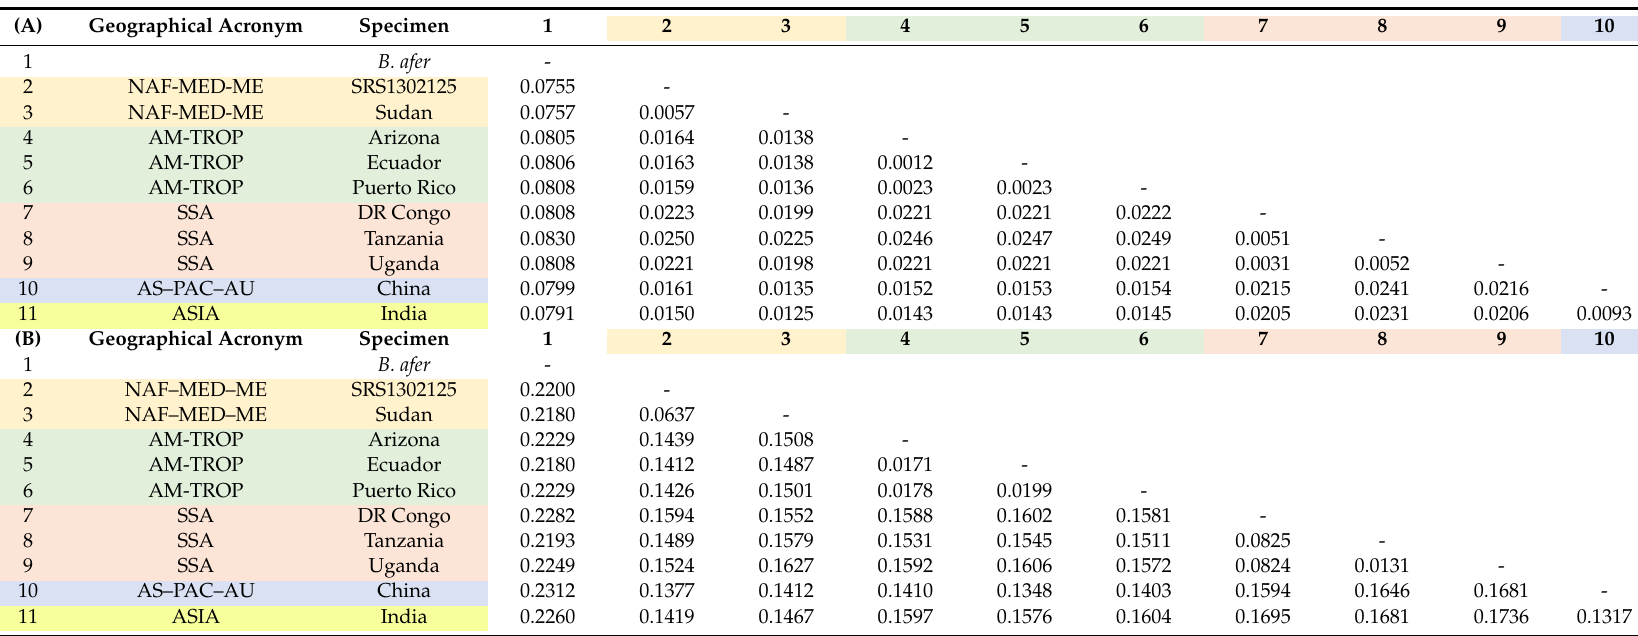
Table 3. Colors of rows correspond to putative species suggested by ABGD analyses. A) Uncorrected pairwise distances among B. tabaci individuals based on the nuclear supermatrix of 2184 genes. B) Uncorrected pairwise distances among individuals based on COI